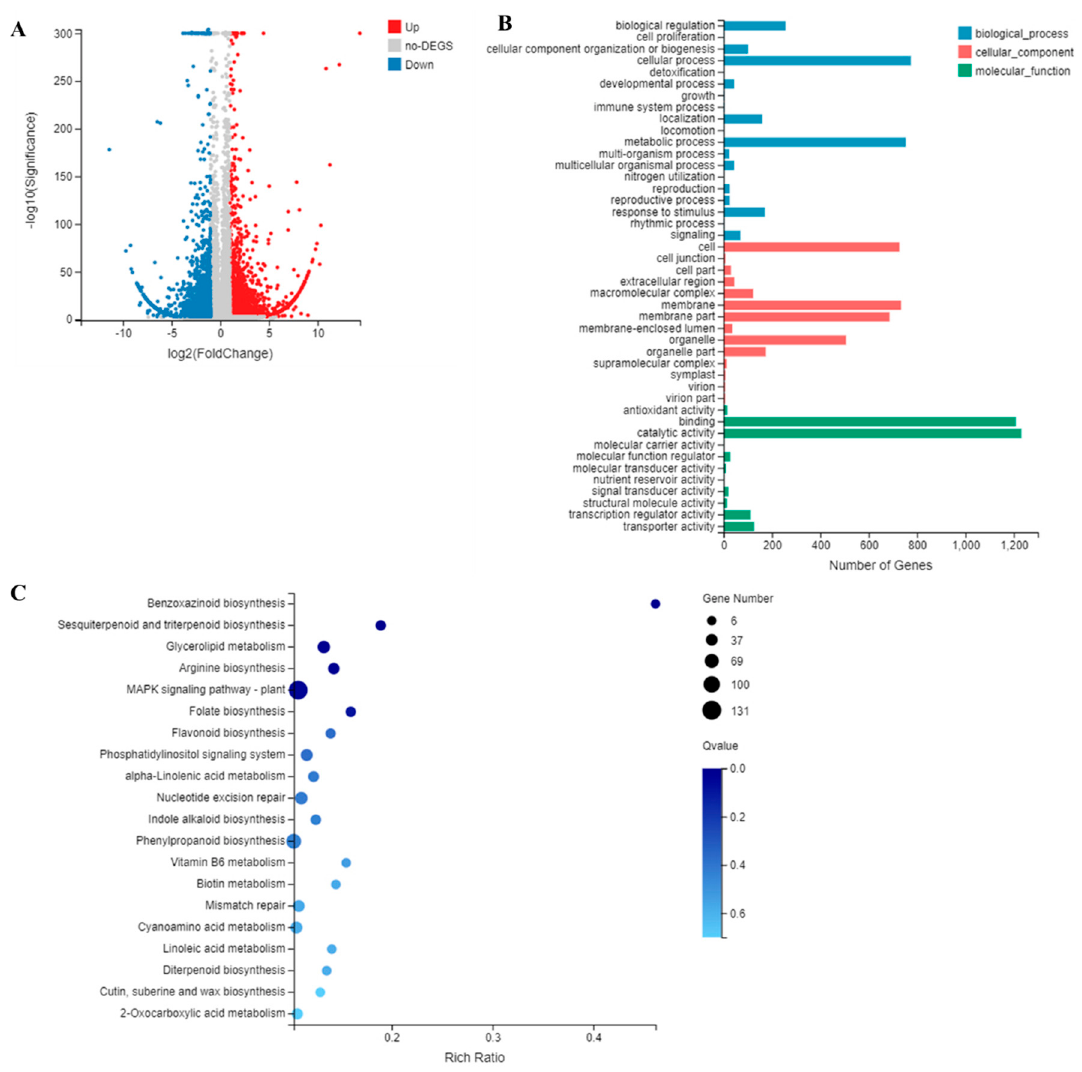
Figure 4. RNA-Seq analysis of MIM319 transgenic sweet potato and WT. ( A ): Volcano plot shows the differentially expressed genes (DEGs) between MIM319 transgenic sweet potato and WT. Blue circles represent downregulated DEGs; red circles represent upregulated DEGs; and grey circles represent non-DEGs. ( B ): GO analysis of the DEGs between MIM319 transgenic sweet potato and WT. ( C ): KEGG pathway analysis of the DEGs between MIM319 transgenic sweet potato and WT.